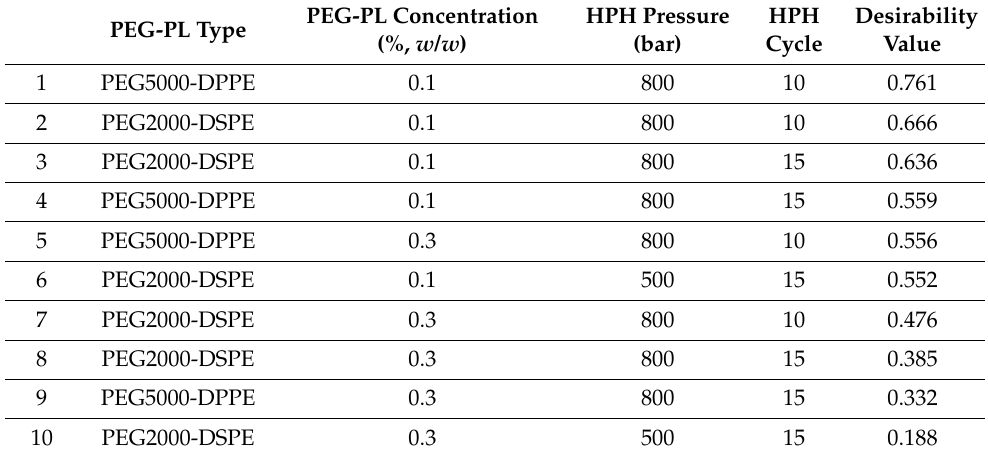
Table 2. Numerical optimization of the formulations selected via experimental